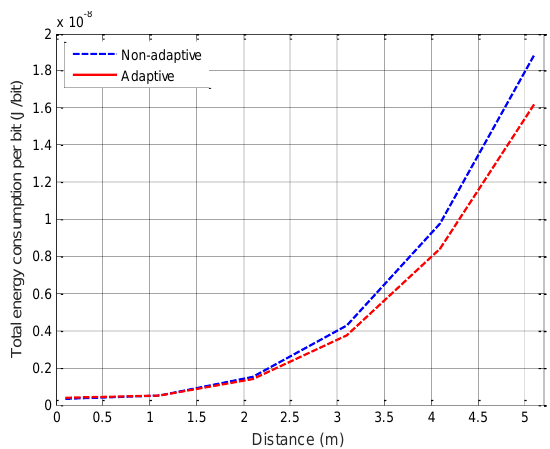
Figure 5 . Comparison of energy efficiency as a function of distance between the non-adaptive and the adaptive WBAN systems in 2I1O.